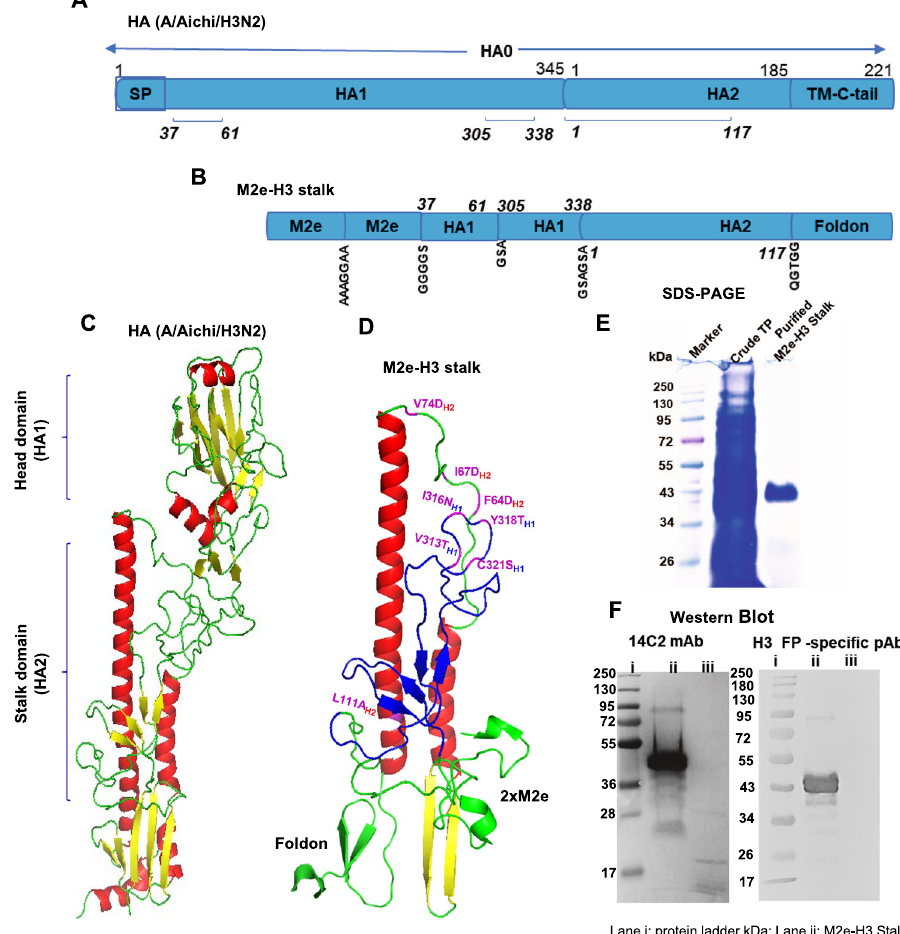
Fig. 1 Rationale design of chimeric M2e-H3 stalk protein, puri fi cation, and con fi rmation. A Schematic of full-length HA gene of in fl uenza A virus (A/Aichi/H3N2), and the selective domains as a vaccine target are numbered in amino acid (aa 37-61, 305-338, 1-117) residues. B M2e-H3 stalk vaccine construct with fl exible and soluble linker sequences (AAAGGAA; GGGGS; GSA; GSAGSA; QGTGG). C The monomeric H3 HA 3D cartoon structure as predicted by the SWISS model and visualized in PyMol. D Illustration of monomeric cartoon structure of M2e-H3 stalk domain marking the positions of point mutations. M2e and foldon structures were modeled using PDB ID codes 4N8C and 1RFO, respectively. E Coomassie Blue staining of M2e-H3 stalk protein. Marker: protein size marker (kDa), Crude TP: Total cell lysates (25 µg); M2e-H3 stalk: puri fi ed M2e-H3 stalk protein (15 µg). F Western blot of M2e-H3 stalk protein. 14C2: M2e-speci fi c mAb; stalk: anti-fusion peptide (FP) polyclonal antibody (pAb) recognizing HA2 aa1-14 epitope. E , F The original un-cropped images of all blots including full molecular weight markers are provided in the supplementary information fi le (Supplementary Figure